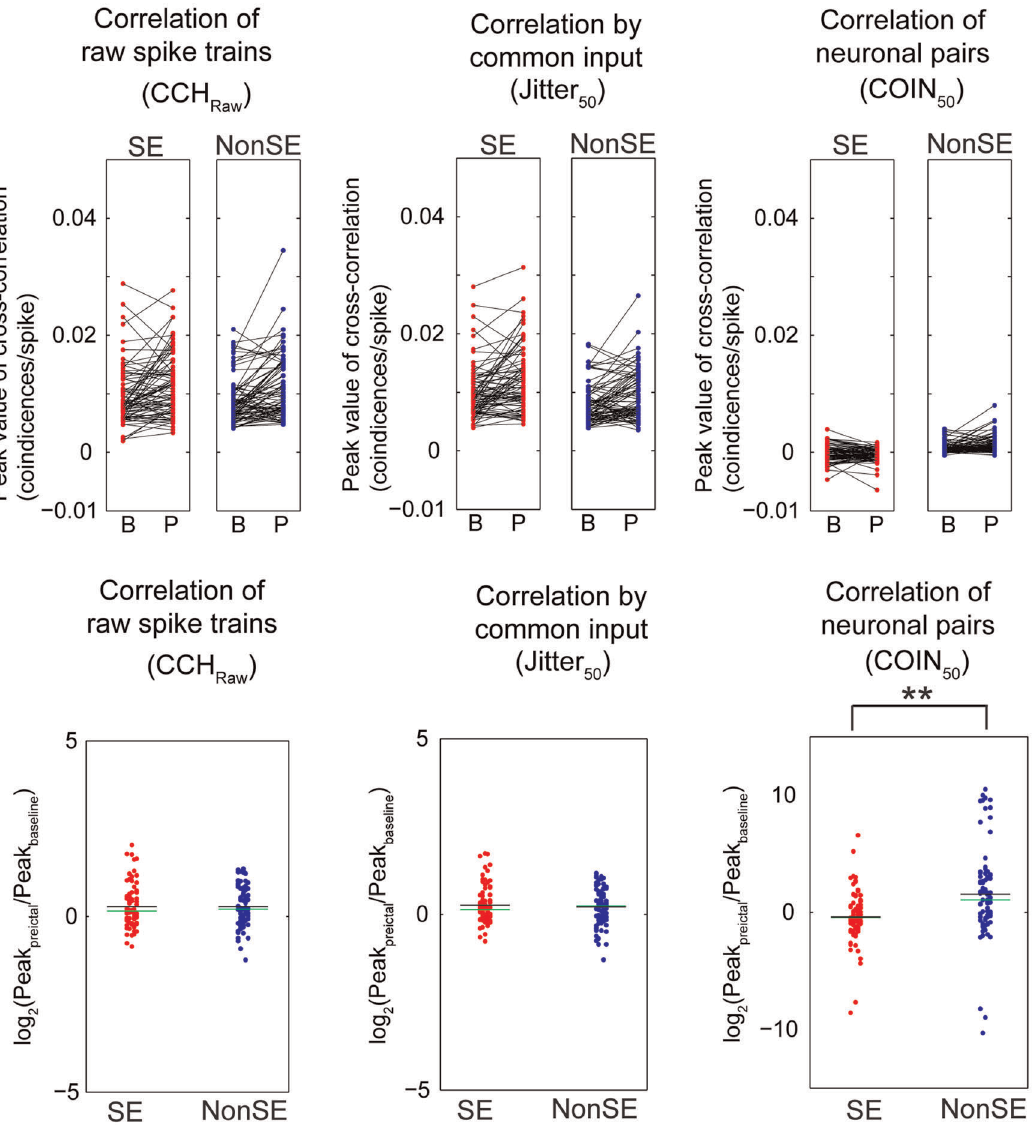
Figure 6. Changes in functional connectivity across all neuronal pairs from cross-correlation analysis. Upper panel shows the raw correlation (CCH raw ), correlation driven by common input (Jitter 50 ), and correlation of neuronal pairs (COIN 50 ) based on peak values at baseline and early preictal periods. Lower panel shows log ratios of the coincident peak of early preictal period to that of baseline period. The vertical scatter plots integrate the distributions of all ratio results in CCH raw , Jitter 50 , and COIN 50 . Each data point represents a result from one neuronal pair. The mean peak ratio is indicated by black horizontal line, and the median peak ratio is shown in green. The correlation value of neuronal pairs was significantly larger in nonSE rats than SE rats.